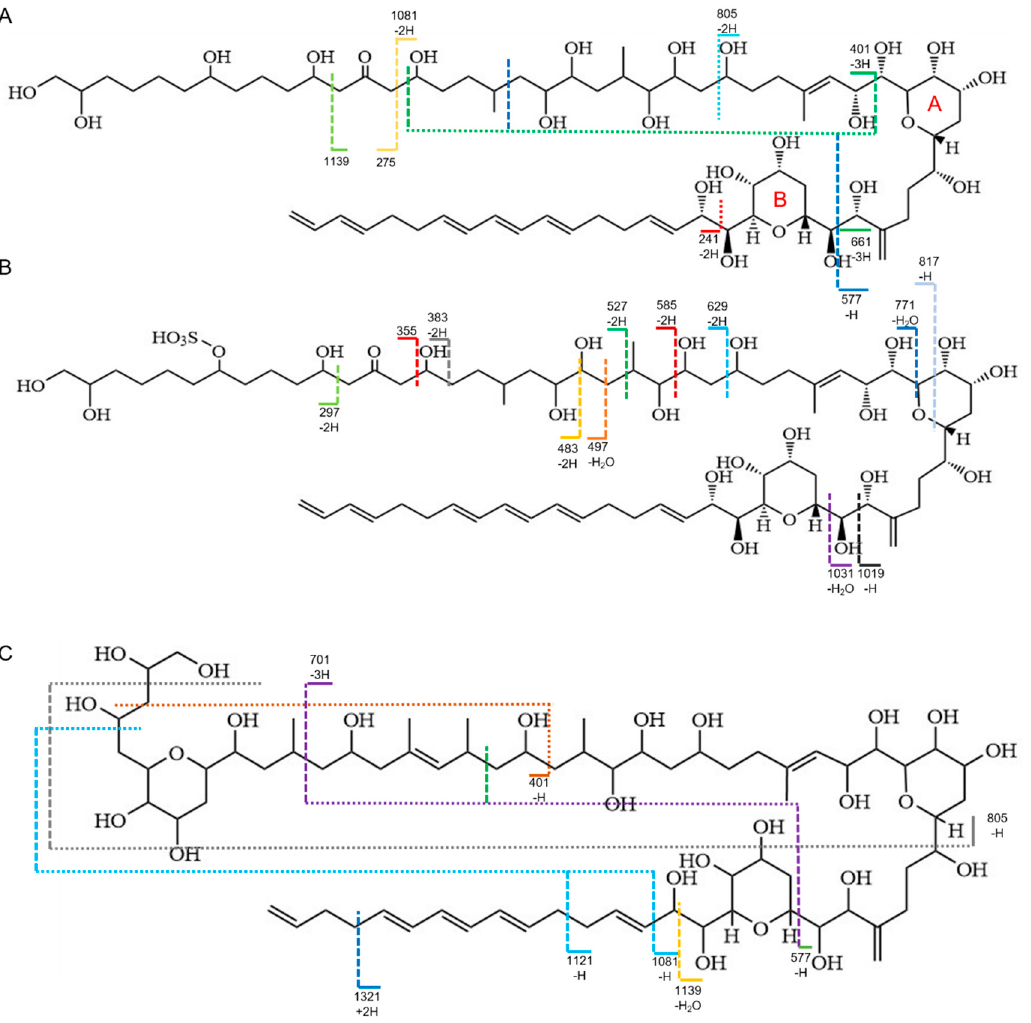
Figure 2. Main MS/MS fragments observed for amphidinol 18 ( A ), amphidinol 19 ( B ), and amphidi- nol 2 ( C ). Table 1. Exact masses, elemental composition, and error between empirical and theoretical masses of AMs.